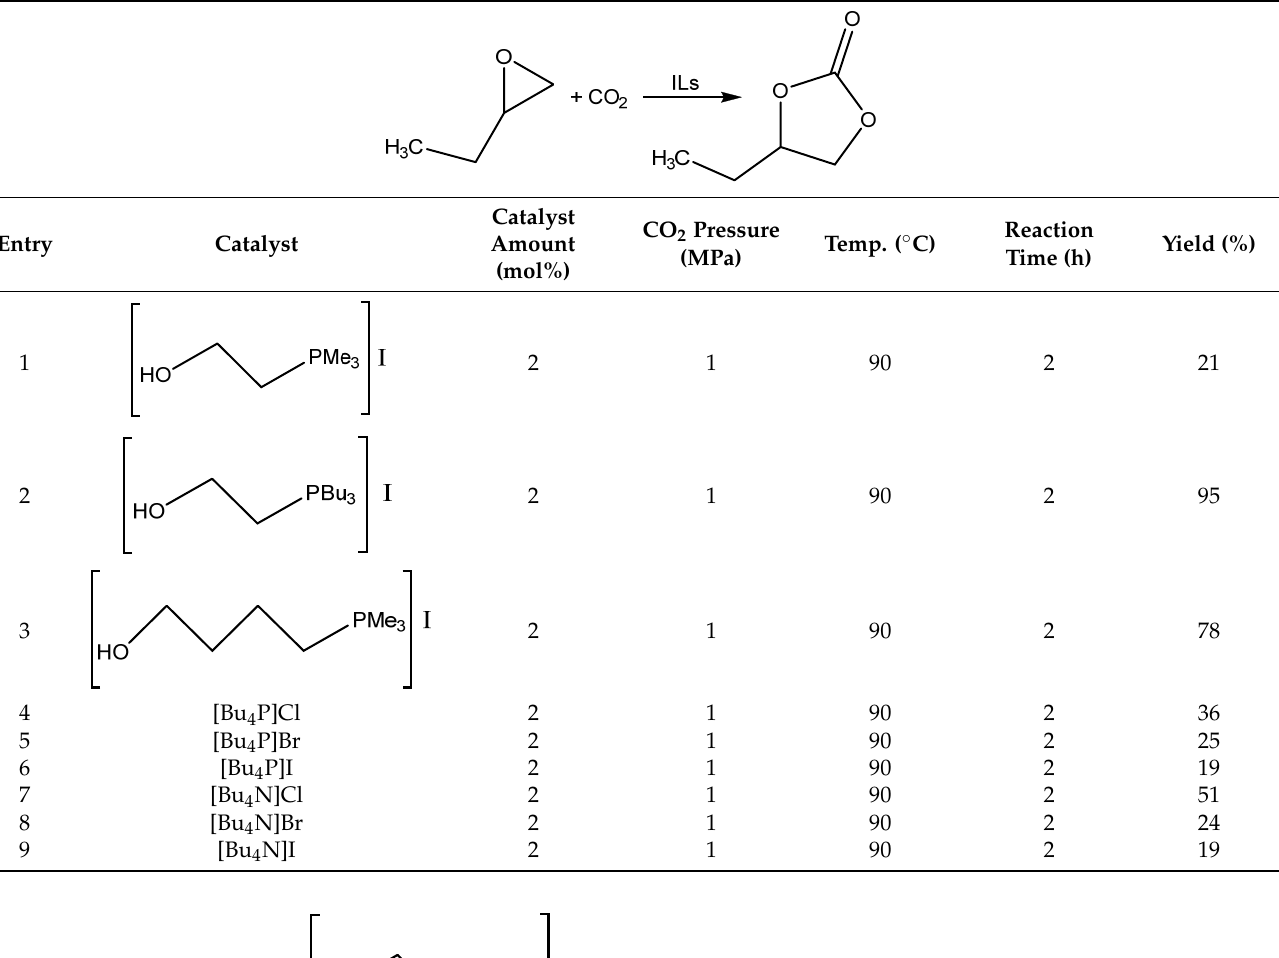
Table 22. Carbonation of butylene oxide (BO) using bifunctional phosphonium salts and onium salts [93].